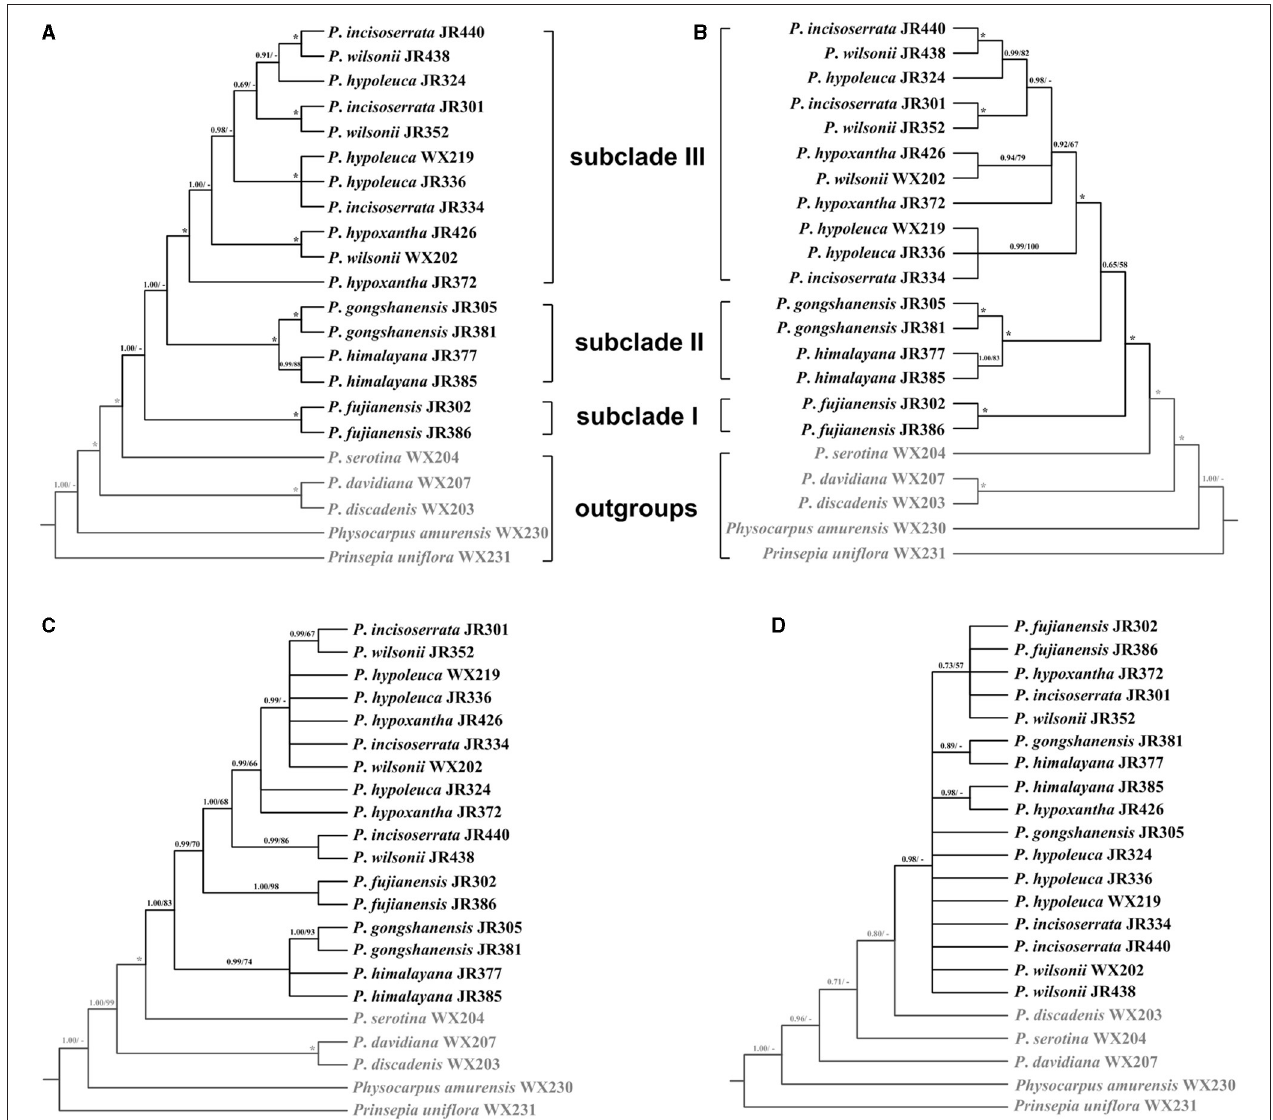
FIGURE 7 | Phylogenetic relationships of the Maddenia group of Prunus inferred from Bayesian inference (BI) and maximum likelihood (ML) based on four datasets. (A) complete plastomes; (B) hypervariable regions; (C) rbcL + matK + trnH-psbA ; (D) internal transcribed spacer (ITS) sequence. The support values above the branches show PP (posterior probability) / BS (bootstrap support), and asterisks indicate 1.00/100%. Dashes represent incongruences of BI and ML